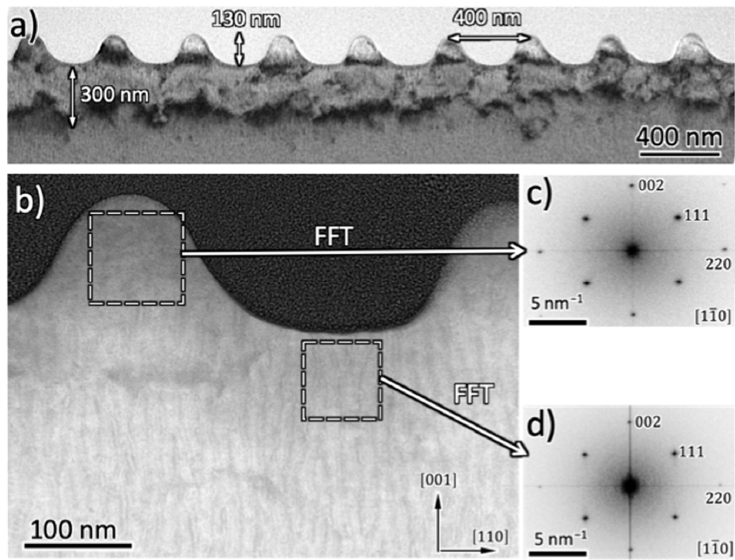
Figure 9. ( a ) TEM brightfield image of a cross-section of a sample showing type A3 nanostructures on a Ni5W tape after laser irradiation. ( b ) Detail of the formed nano-protrusions of the same